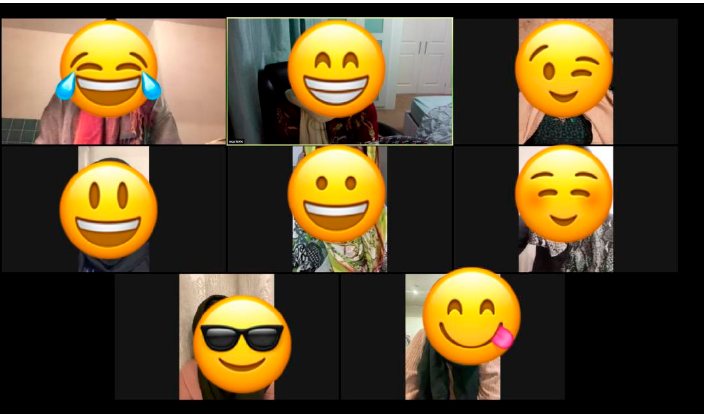
Figure 6. A “virtual iftar party” with friends (Mubeena, Diary Image, Entry 5—‘emojis’ added by participant).